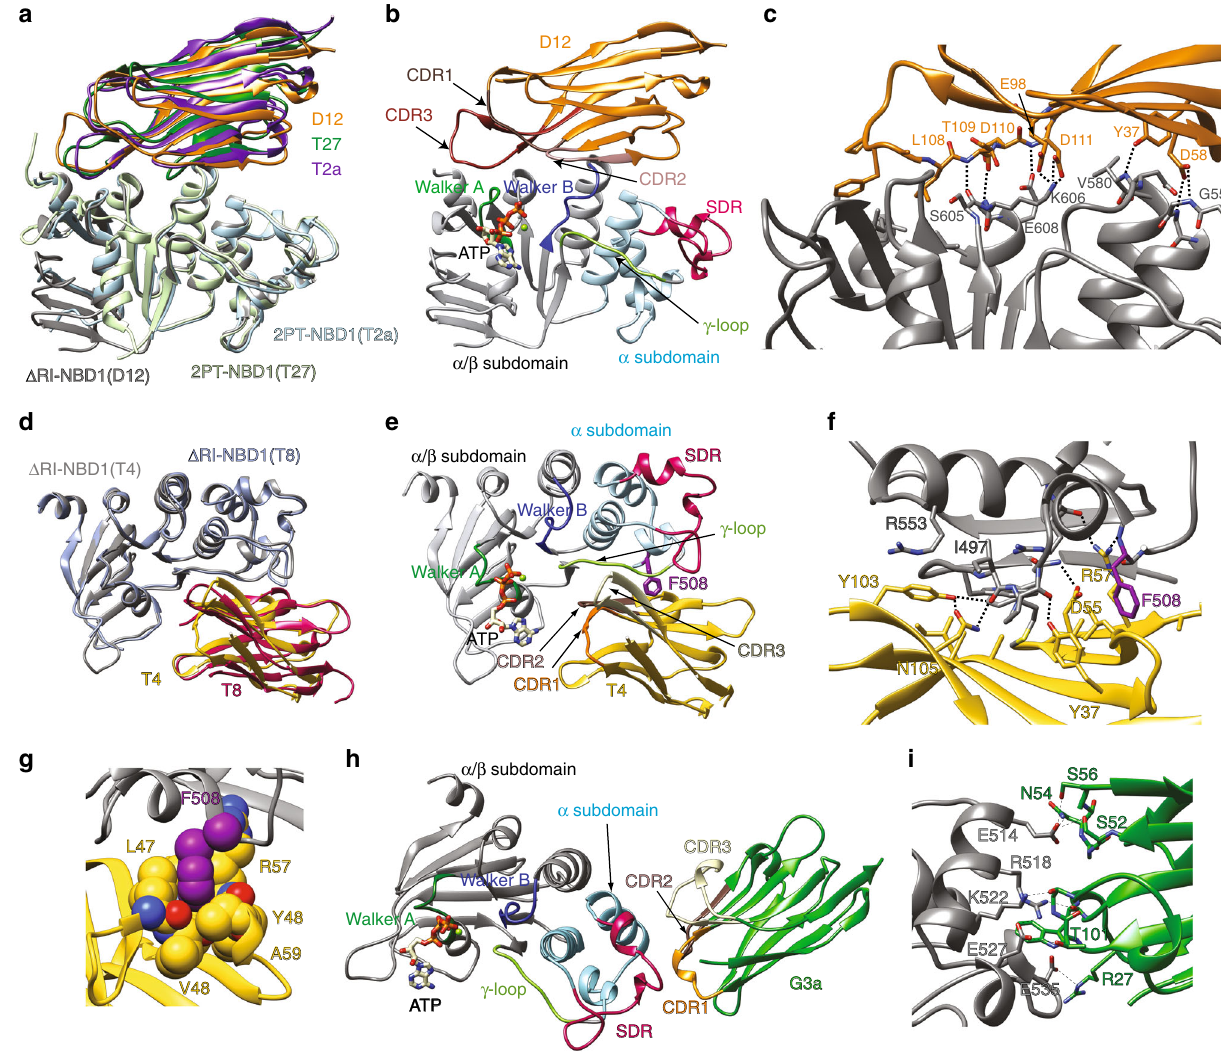
Fig. 3 Crystal structures of NBD1-nanobody complexes. a Structures of nanobodies D12, T2a and T27 bound to NBD1. Superimposition was performed on the NBD1 region. b Structure of NBD1-nanobody D12 complex highlighting the different structural elements of hNBD1 as well as the CDRs of the nanobody. c Details of the interface between nanobody D12 and NBD1. Polar interactions are highlighted by dashed lines (see text for description). Only side chains participating in the interface are explicitly shown. d Structures of nanobodies T4 and T8 bound to NBD1. Superimposition was performed on the NBD1 region. The view is rotated compared to ( a ). e Structure of NBD1-T4 nanobody complex highlighting the different structural elements of NBD1 as well as the CDRs of the nanobody f Details of the interface between nanobody T4 and NBD1. Polar interactions are highlighted by dashed lines (see text for description). Only side chains participating in the interface are explicitly shown. g Close-up of the interaction of F508 from NBD1 to residues in T4. Atoms are shown as space- fi lling model to highlight the contacts, occurring at van der Waals distances. h Structure of NBD1-G3a nanobody complex i Details of the interface between nanobody G3a and NBD1. Polar interactions are highlighted by dashed lines (see text for description). Only side chains